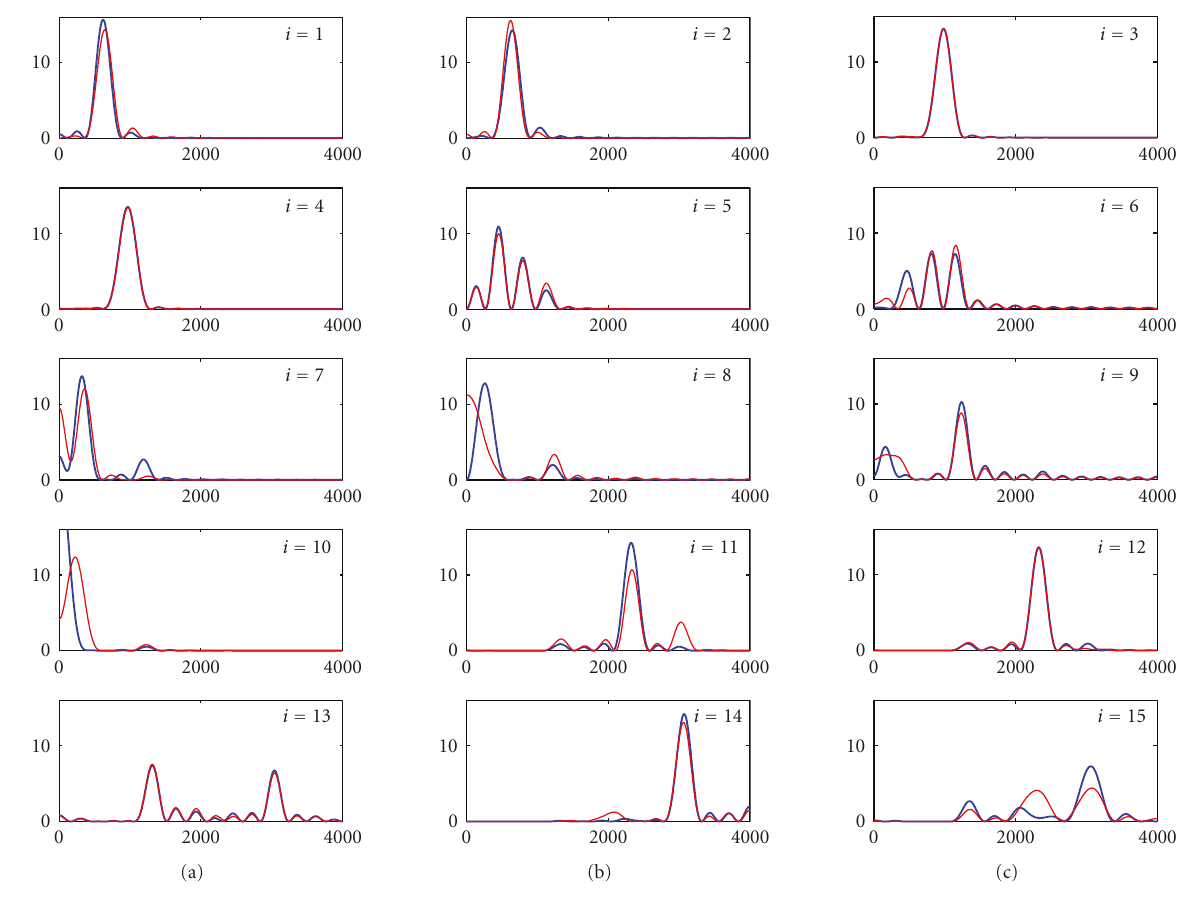
Figure 9: Frequency responses (Magnitude (dB) versus Frequency (Hz)) of the combined FIR filter pairs for the SVD algorithm (thick blue lines) and the low-rank ULV algorithm lulv (thin red lines) applied to the test problem in Figure 5. Both algorithms compute the MV estimates, and the filters are computed by means of (73) and